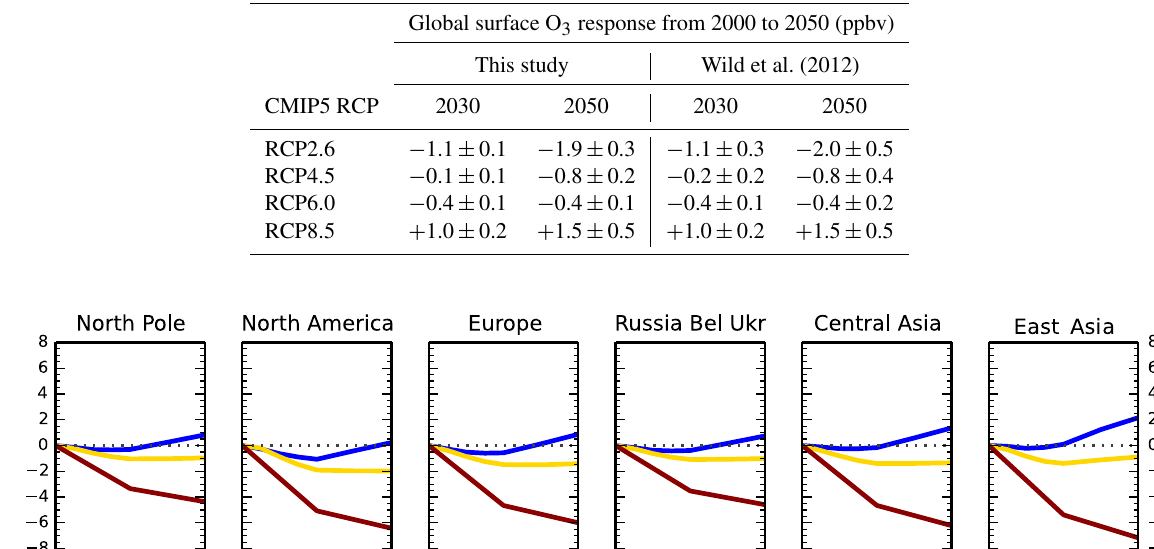
Table 7. Annual mean surface O 3 change (ppbv plus 1 standard deviation) in 2030 and 2050 (relative to 2000) for each RCP scenario derived from the parameterisation in this study and that of Wild et al. (2012).